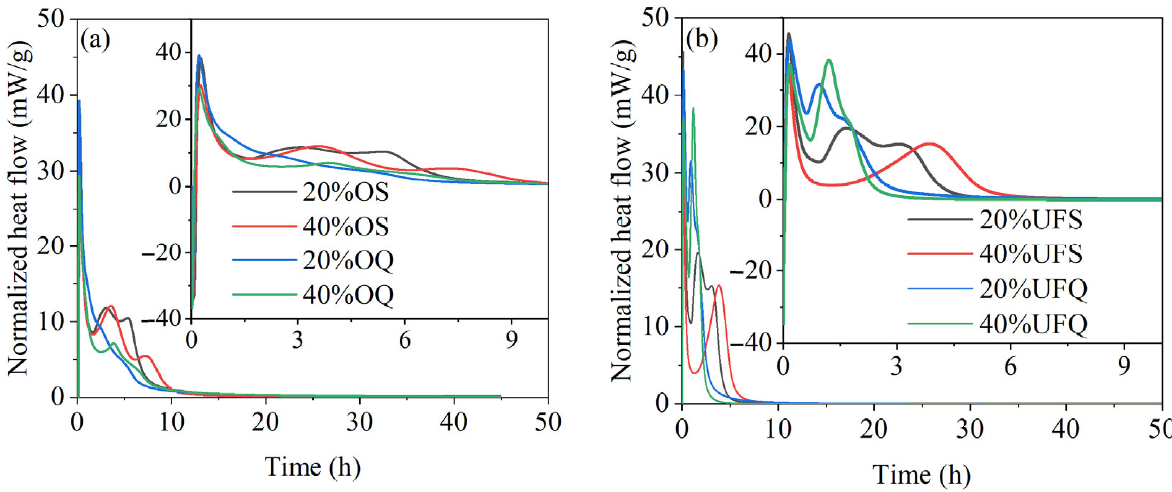
Figure 6. Exothermic rates of MKPC containing quartz or slag. ( a ) addition of ordinary powder; ( b ) addition of ultrafine powder.